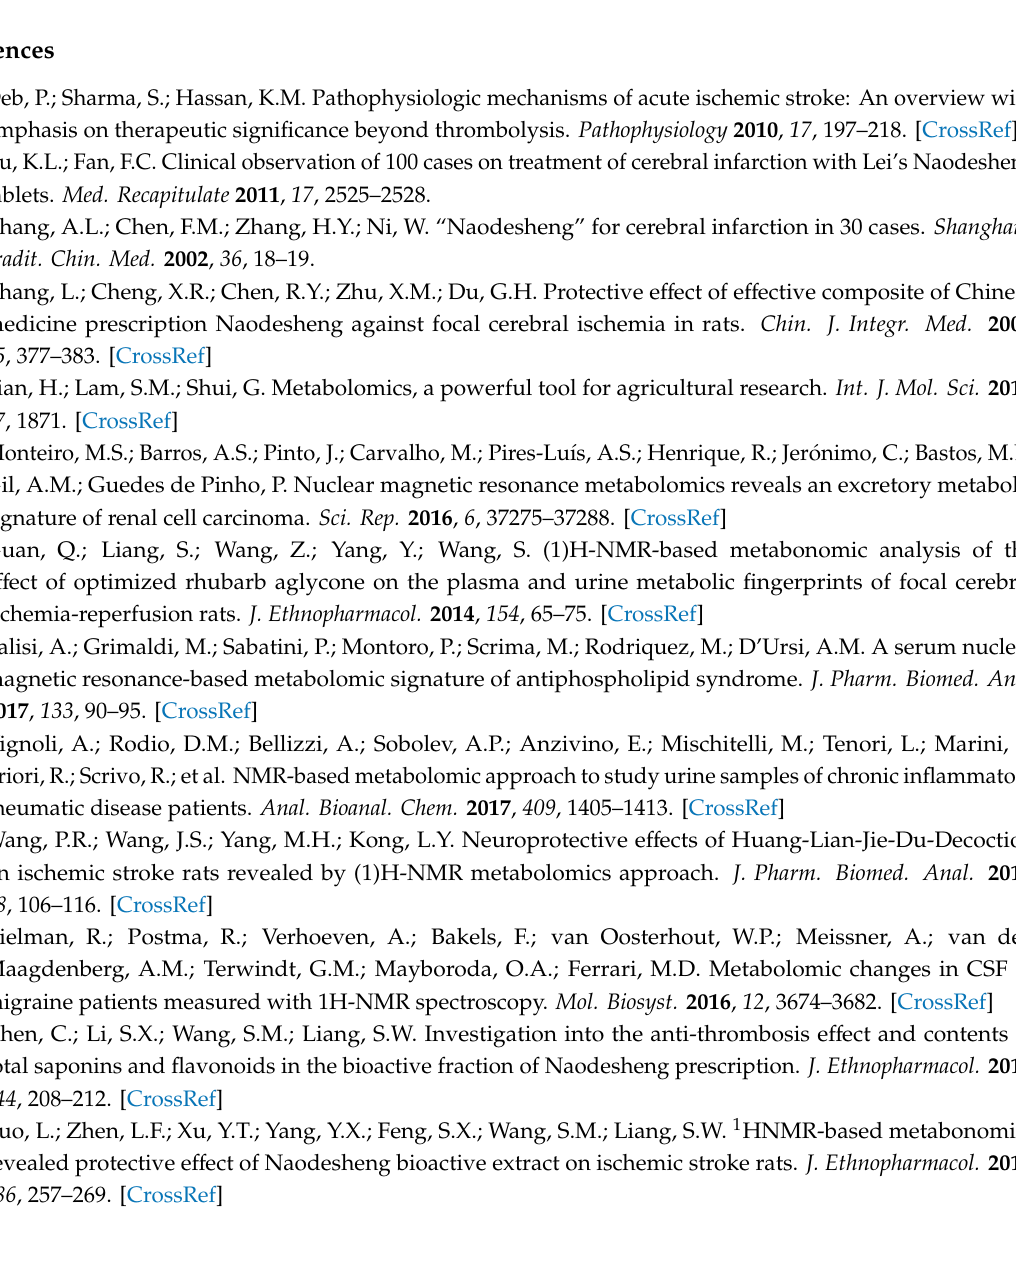
tissue, Figure S6: 1 H- 13 C HSQC spectrum of model rat brain tissue, Figure S7: PCA scores plots for five groups from plasma (A), urine (B) and brain tissue (C), Figure S8: Plasma PLS-DA validation plots for model group vs control group (A), model group vs nimodipine group (B), model group vs H-TCNDS group (C), and model group vs L-TCNDS group (D), Figure S9: Urine PLS-DA validation plots for model group vs control group (A), model group vs nimodipine group (B), model group vs H-TCNDS group (C), and model group vs L-TCNDS group (D), Figure S10: Brain PLS-DA validation plots for model group vs control group (A), model group vs nimodipine group (B), model group vs H-TCNDS group (C), and model group vs L-TCNDS group (D), Table S1: 1 H-NMR data and assignments of the metabolites in rat plasma, Table S2: 1 H-NMR data and assignments of the metabolites in rat urine, Table S3: 1 H-NMR data and assignments of the metabolites in rat brain tissue, Table S4: The PLS-DA model parameters between model group and other groups from plasma, urine and brain